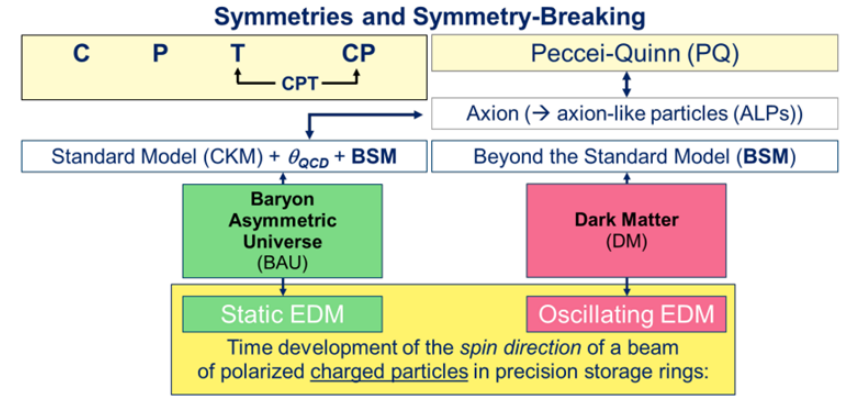
Figure 3. Summary of the scientific background: discrete symmetries (C, P, T, and combinations thereof) and the presumed Peccei – Quinn symmetry (PQ) together with their breaking (CP and PQ symmetry violation) can be related to static and oscillating EDMs. Static EDMs may be responsible for the Baryon-asymmetric Universe (BAU), while oscillating EDMs could be due to the axion and/or axion-like particles (ALP) as Dark Matter candidates. Experimentally, both can be investigated by a measurement of the time development of the spins of a beam of charged particles circulating in a storage ring.